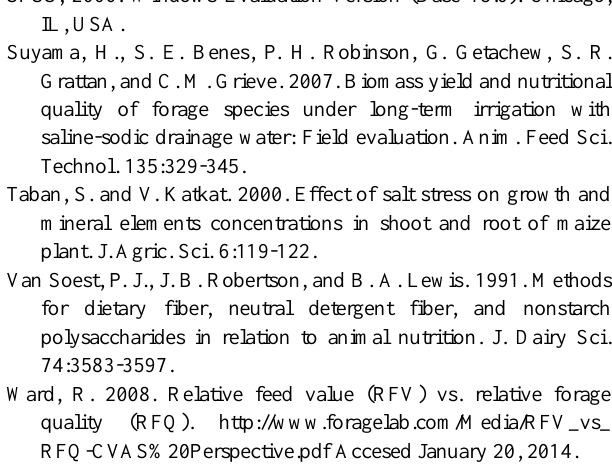
Taban, S. and V. Katkat. 2000. Effect of salt stress on growth